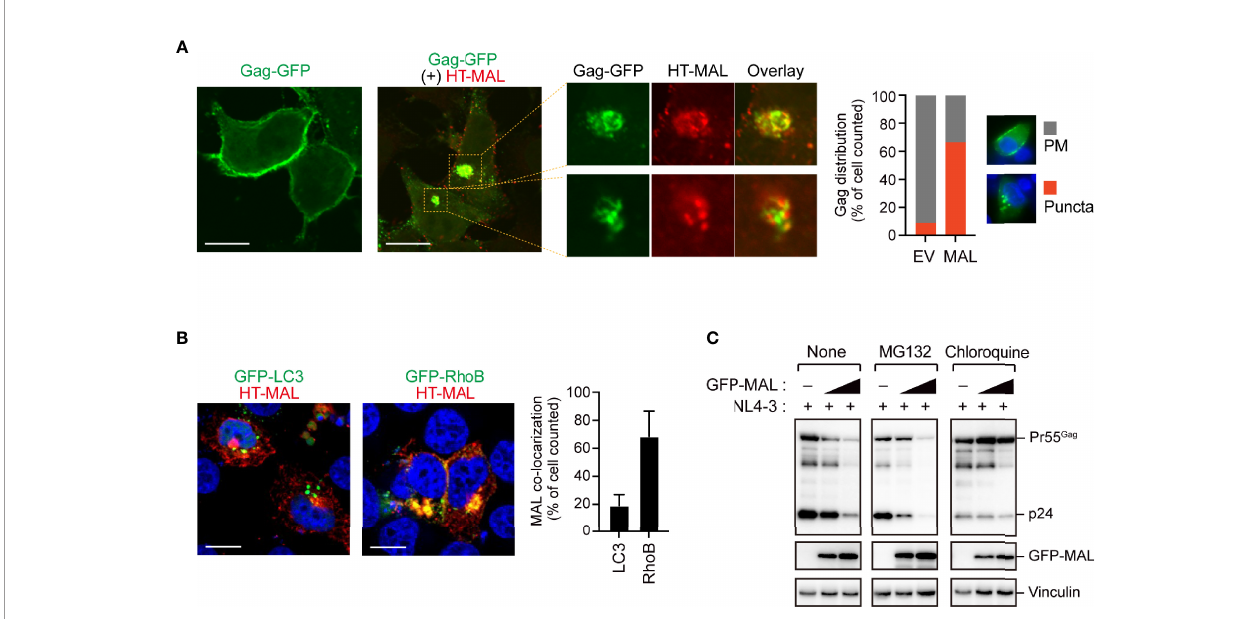
FIGURE 3 | MAL inhibits translocation of Gag to the plasma membrane. (A) Confocal microscopy images of HepG2 cells expressing pNL4-3/Gag-EGFP and HaloTag (HT)-conjugated MAL proteins. The third image in this panel is the expanded view. Note that other viral proteins except Pol were expressed in this experiment. Scale bar, 10µm. Low magni fi cation images, including other cells, are shown in Supplementary Figure S3 . The graph on the right shows the percentage of cells in which Gag-GFP localized at the PM or in cytoplasmic puncta ( n > 20 cells). (B) Confocal micrographs showing HepG2 cells expressing HT- MAL and either GFP-LC3 (autophagosomal marker) or GFP-Rho3 (endosomal marker). Nuclei were stained with DAPI. Scale bar, 10µm. The graph on the right shows the percentage of cells in which MAL localized to LC3- or RhoB-positive structures ( n > 20 cells). (C) Lysosomal inhibitor blocks MAL-mediated Gag degradation. HEK293 cells were co-transfected with pNL4-3 and the MAL expression vectors. Two days post-transfection, cell lysates were subjected to immunoblotting. The compounds indicated in the fi gure were added 16 h before the cells were